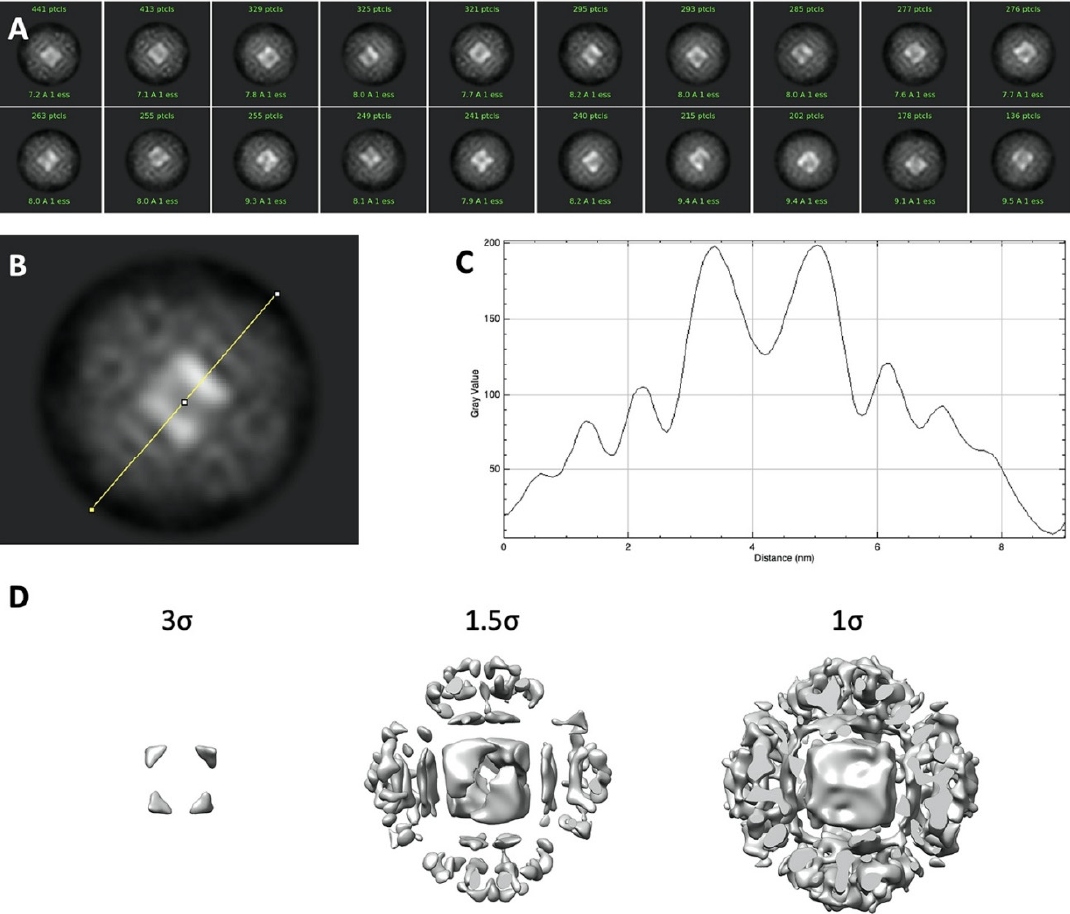
Figure A2. Formation of symmetrical mineral core in Dps-Fe2000 sample incubated for 10 min. ( A ) class averages (~9.5% of particles); ( B , C ) enlarged class average and corresponding intensity profile (measured along the yellow line), demonstrating low-density central region; ( D ) cryo-EM maps of Dps dodecamer with iron core at different thresholds (EMD-14952). Each of 2D class averages ( A , B ) is 12.5 nm wide.